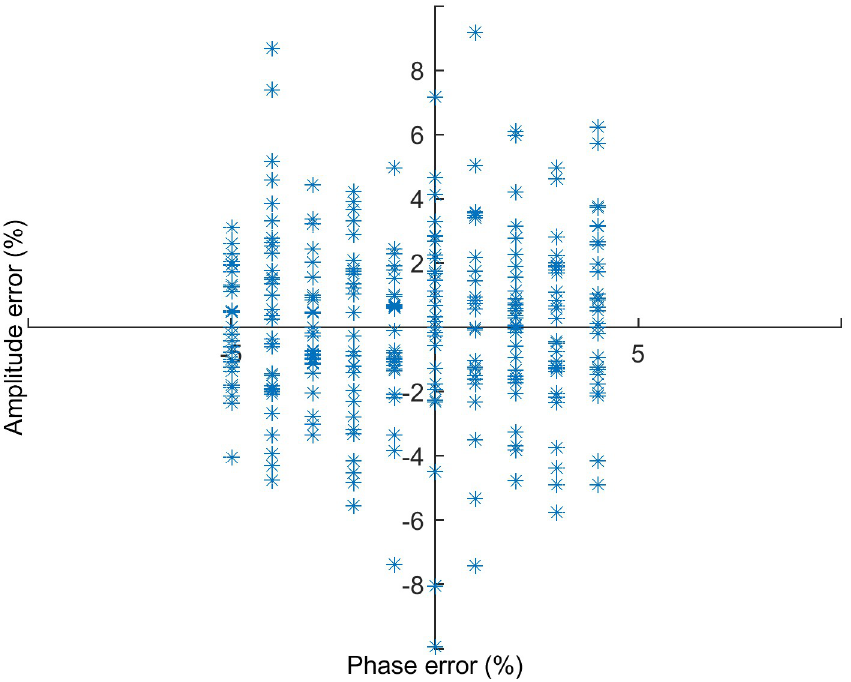
Fig 8. Scatter plot of phase and amplitude error for each CT acquisition